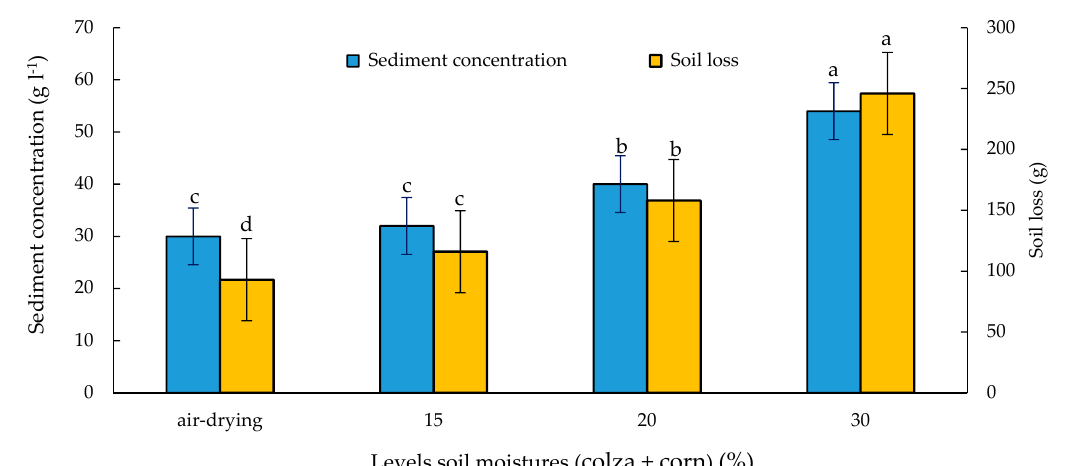
Figure 7. Comparison of soil loss and sediment concentration at different levels of colza + corn straw mulches (above) and soil moisture conditions (below), based on the Duncan test.